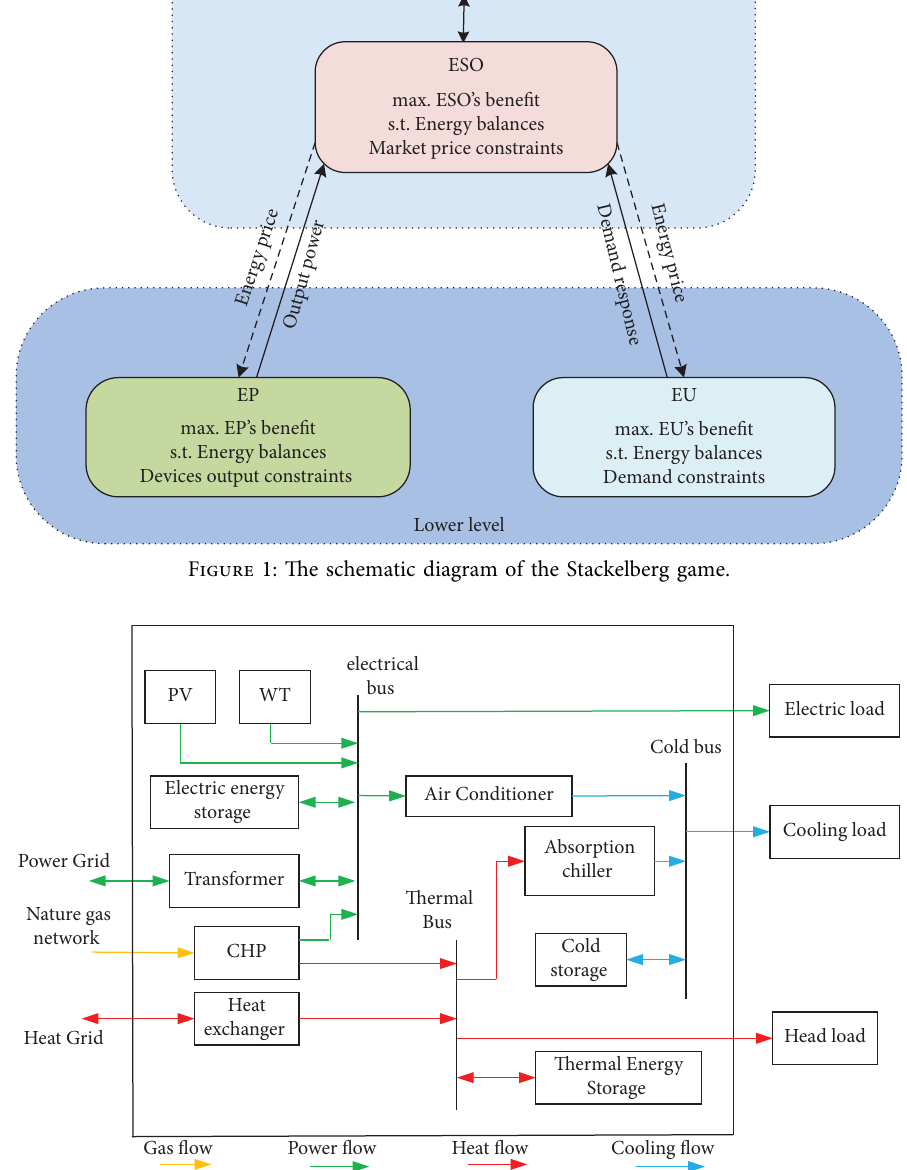
Figure 2: Te schematic diagram of the